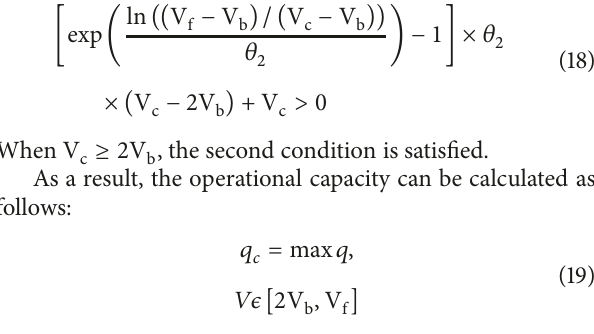
y = 0.9743x - 22.644 R² = 0.9971